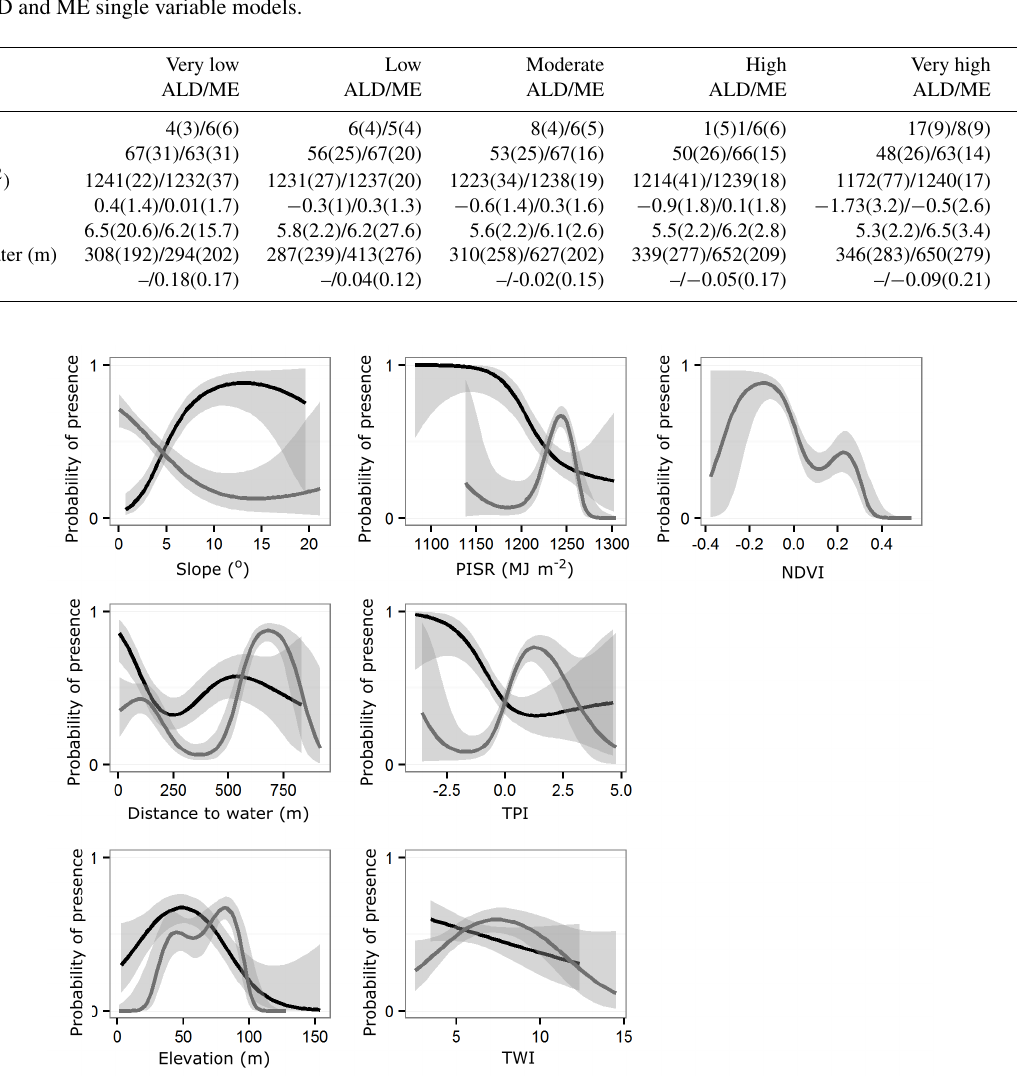
Table 2. Mean and standard deviation (in brackets) values for terrain variables in each susceptibility zone for ALDs and MEs and performance metrics for ALD and ME single variable models.